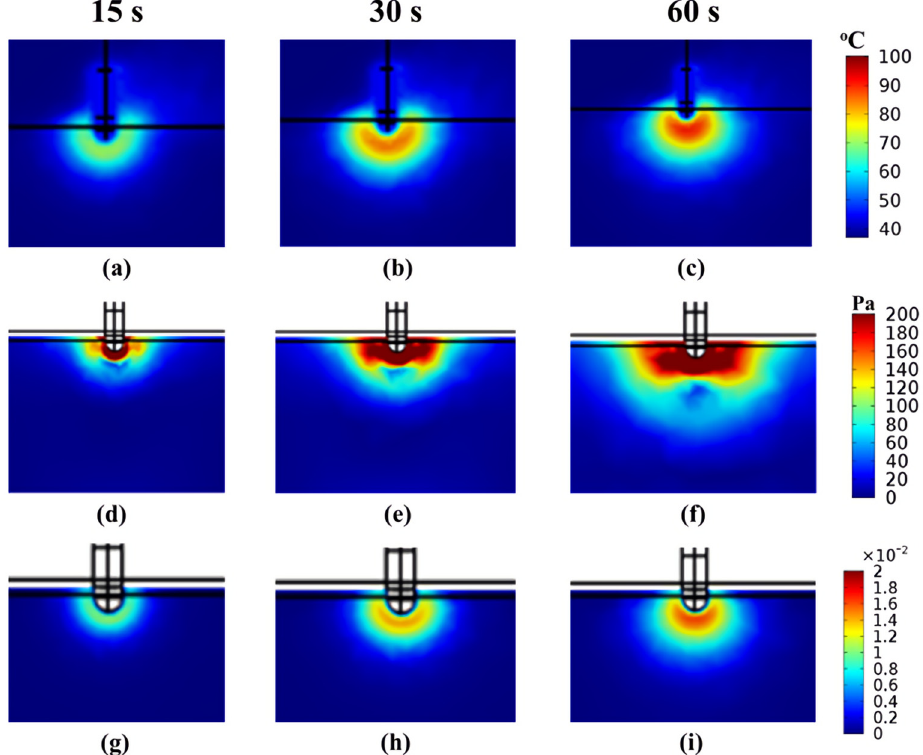
Figure 2. Temporal evolution of: ( a − c ) temperature, ( d − f ) von Mises stress, and ( g − i ) volumetric strain distributions during cardiac ablation procedure.